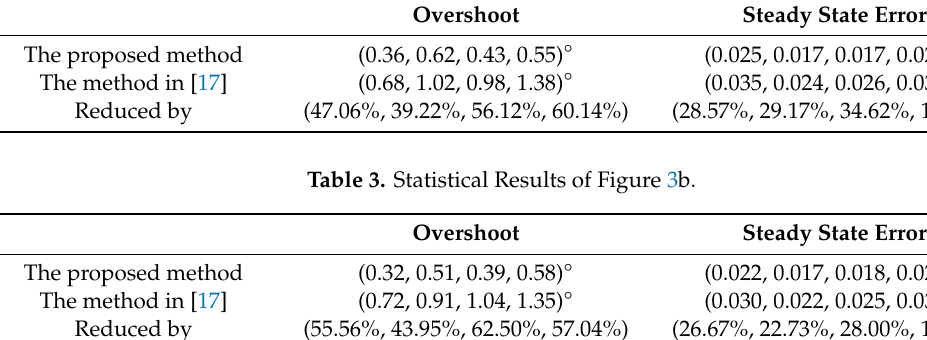
Table 3. Statistical Results of Figure 3b.